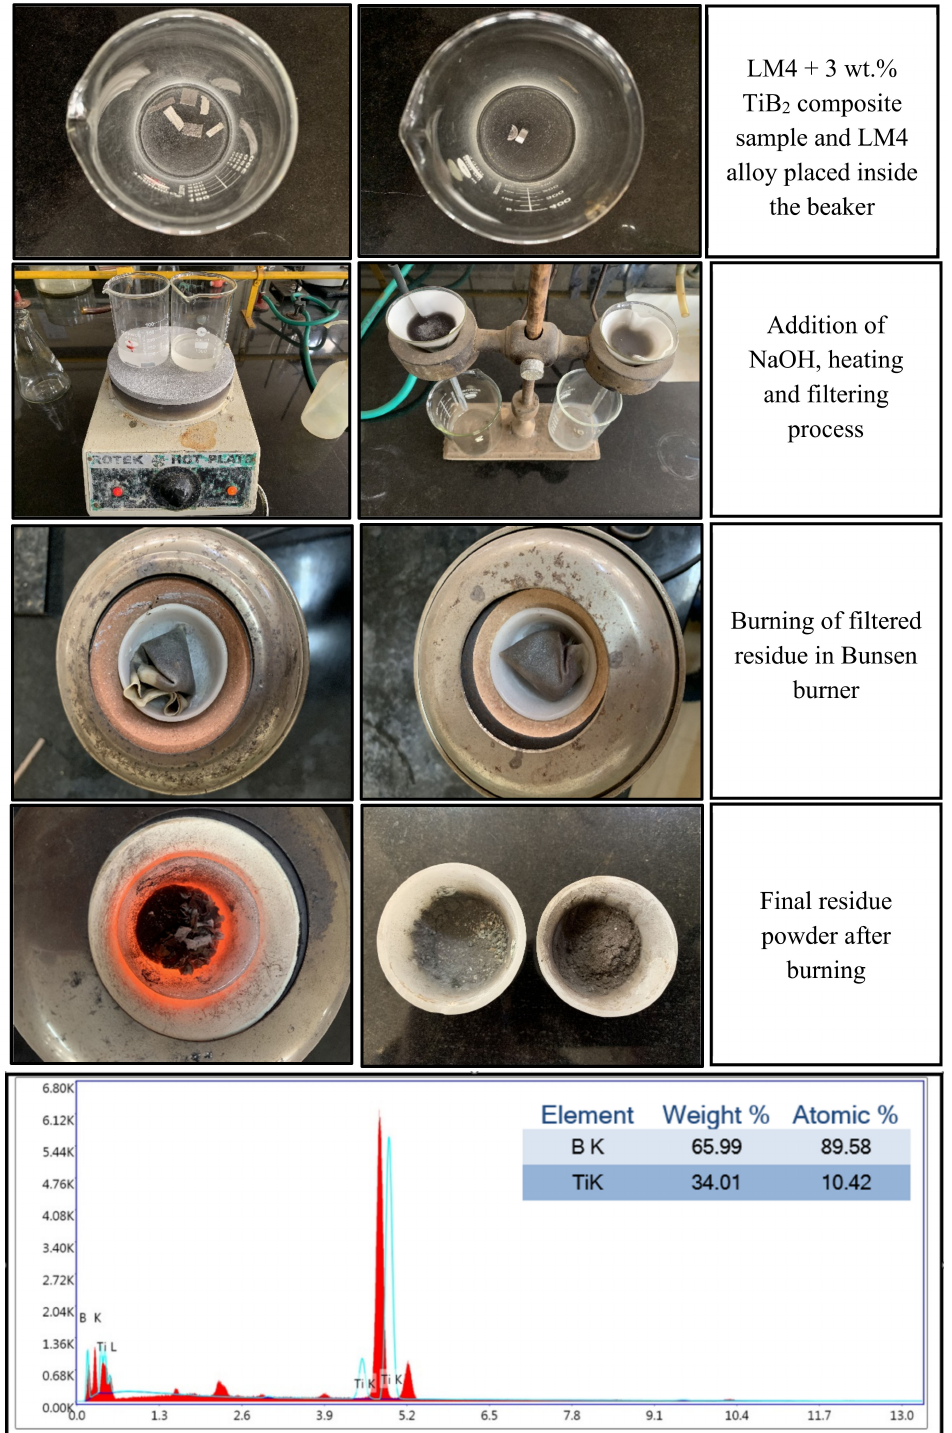
Figure 10. Process of chemical analysis test and EDAX report to confirm the presence of TiB 2 in the LM4